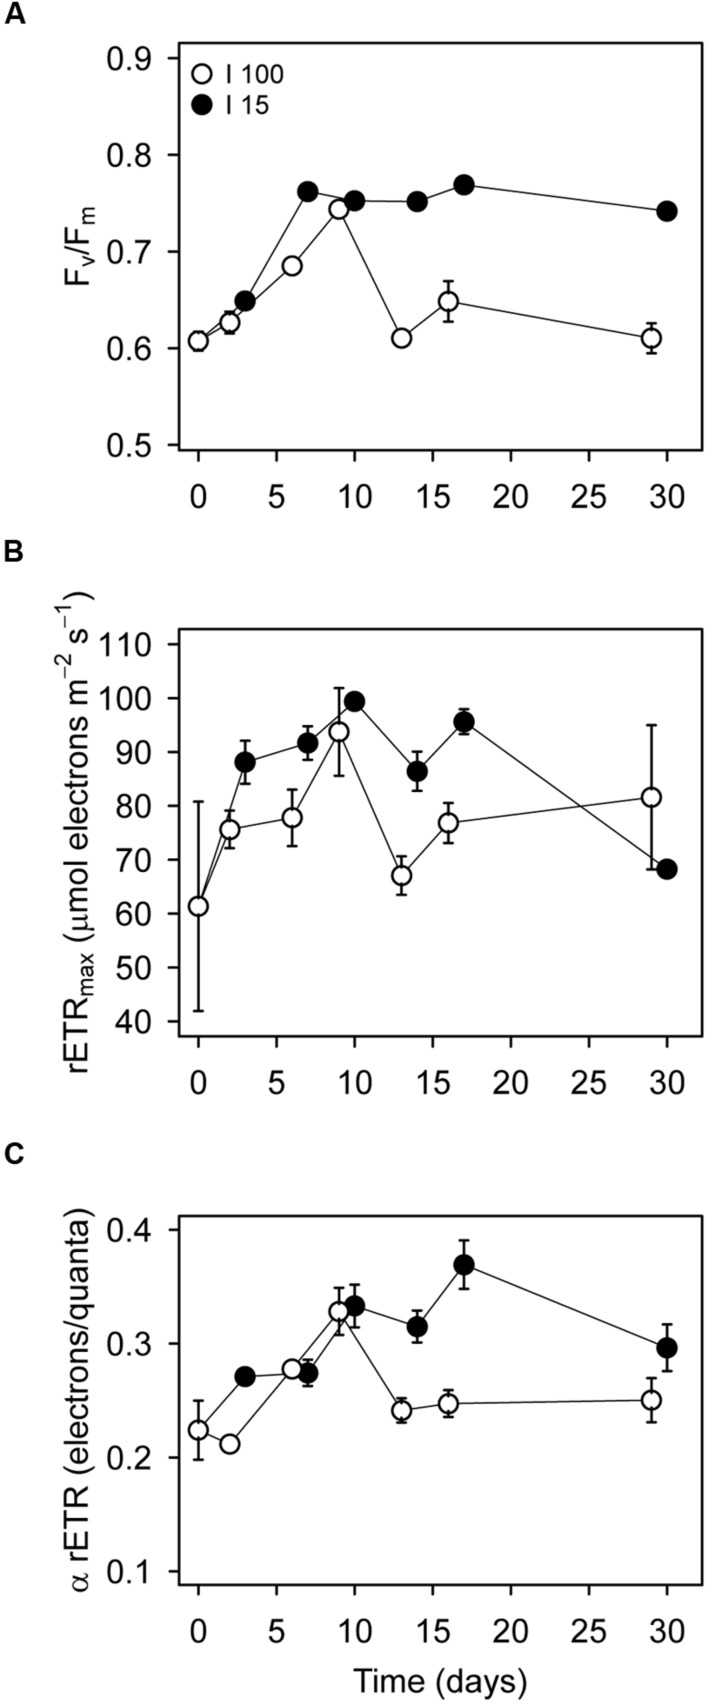
Variable chlorophyll fluorescence measurements on D. acuta culture samples incubated at I100 (o) and I15(●) as a function of time after initiation of prey starvation. The culture had been growing at I100 prior to the initiation of the experiment. (A) Maximum PSII quantum yield (Fv/Fm). (B) Maximum relative electron transport rates (rETRmax) and (C) initial slopes of the light response curves (α rETR), i.e., rETR vs irradiance. Data points represent the mean value parameter estimates obtained from the rapid light response curves. Error bars show standard error of the mean (n = 3).